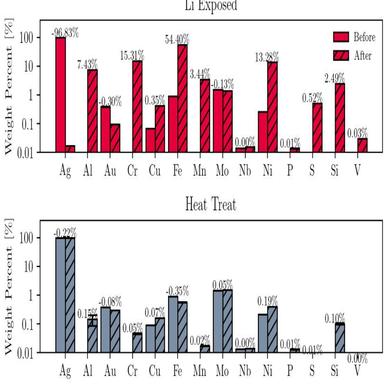
XRF chemical compositions before and after lithium exposure. Like the other analyses, XRF confirms the nearly complete removal of the silver plating. Again, the composition changes to that of the underlying 316 stainless steel. The height of the bars represents the average composition of samples S1-S3. The text above the bars represents the change in chemical composition after lithium exposure.